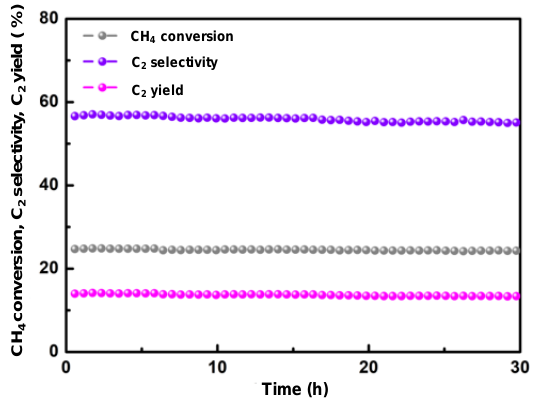
Figure 12. Stability test at 800 °C with the La 1.5 Sr 0.5 Ce 2 O 7 catalyst. Reaction condition: CH 4 :O 2 :N 2 = 4:1:5, WHSV = 72,000 mL·g −1 ·h −1 [89] .